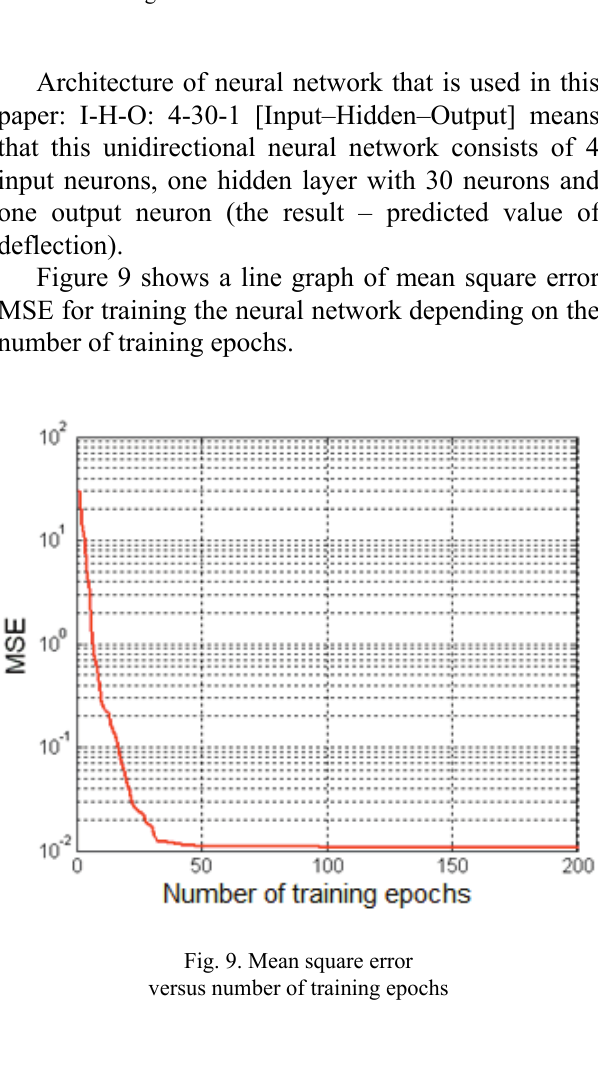
Fig. 8. Structure of the neural network